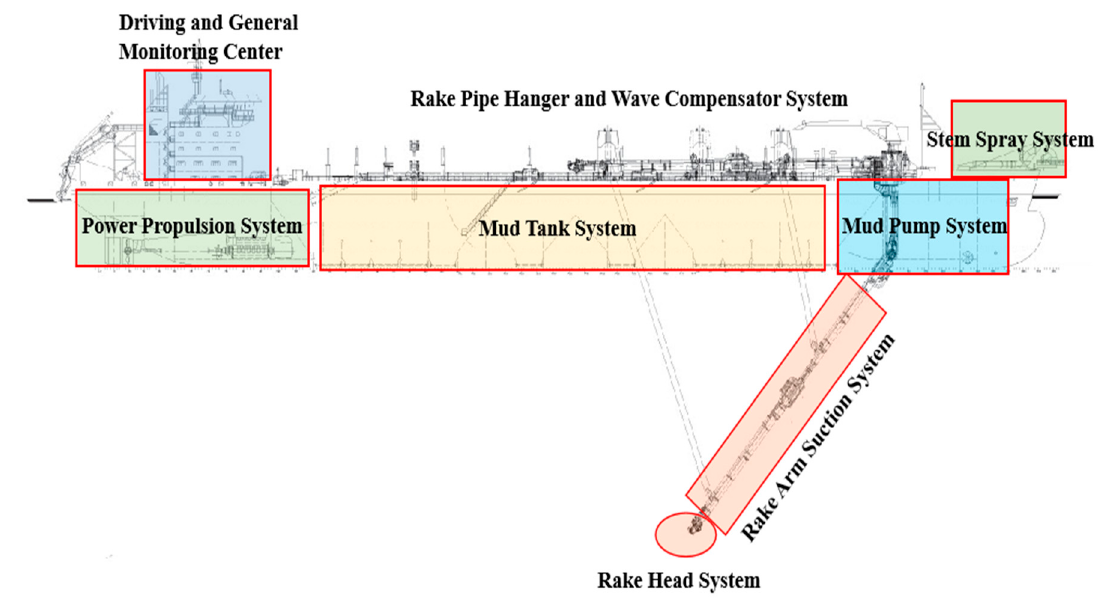
Figure 1. Main components of TSHD.